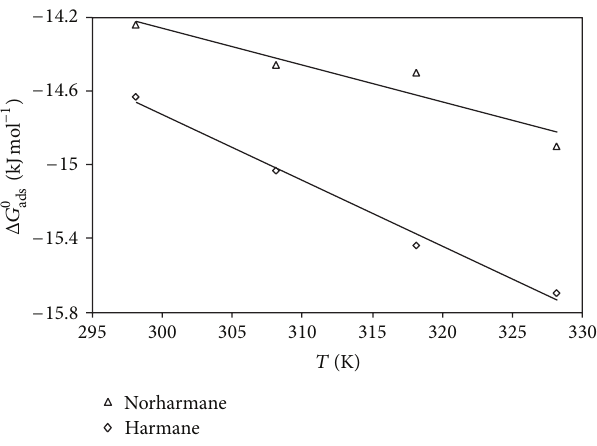
Figure 18: Variation of Δ𝐺 0 , evaluated from IES, versus 𝑇 on C38 ads steel in 1M HCl containing indole derivates.